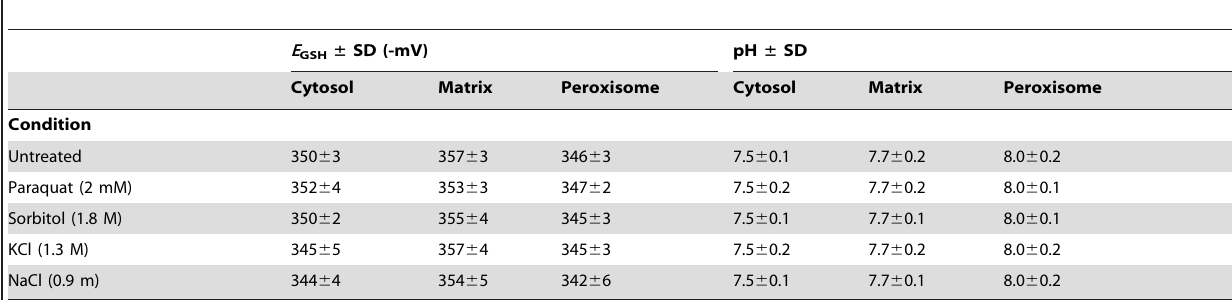
Table 2. E GSH and pH of wild type cells grown in SC URA to exponential phase and treated with various stressors for 1